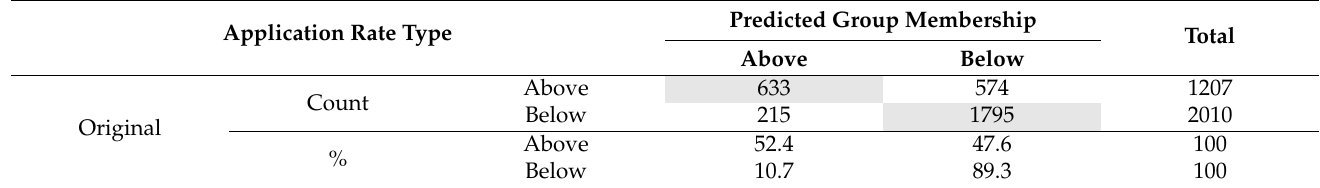
Table 7. Discriminant analysis results with rurality and three factors